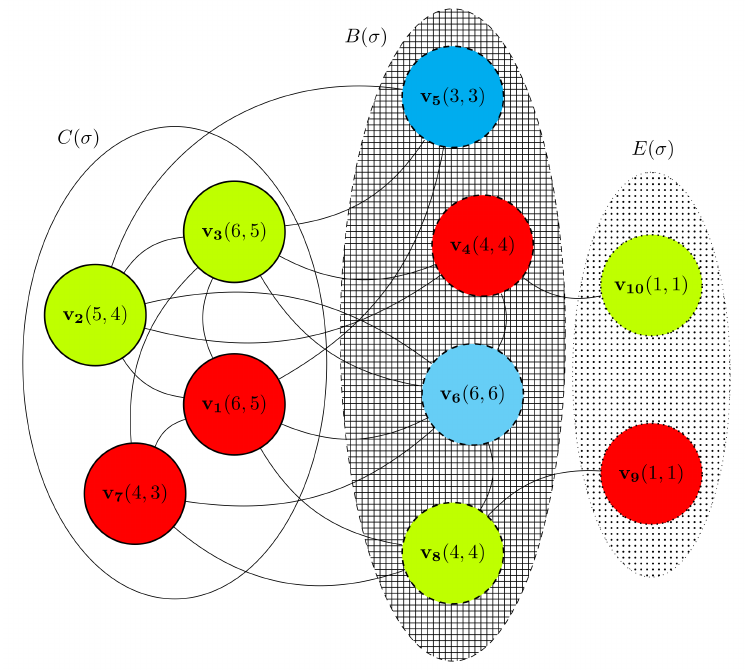
Figure 1. An example of a graph with an optimal coloring partitioned in C ( σ ) = { v 1 , v 2 , v 3 , v 7 } (bold line nodes), B ( σ ) = { v 4 , v 5 , v 6 , v 8 } (dashed line nodes) and E ( σ ) = { v 9 , v 10 } (dotted line nodes). The numbers in bold are the label, while the ones in the brackets indicate the degrees and the payoffs of nodes,